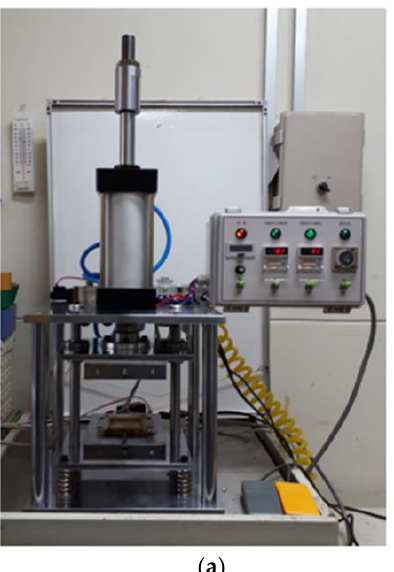
Figure 3. Experiment equipment: ( a ) compression molding and ( b ) compression-molding jig.